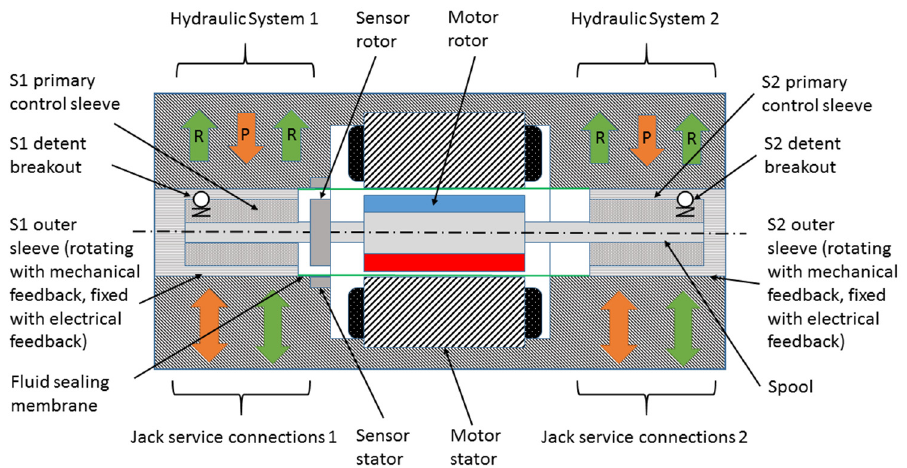
Figure 10. General schematic of the servo; own drawing based on patent [40] and Domin company materials [41].